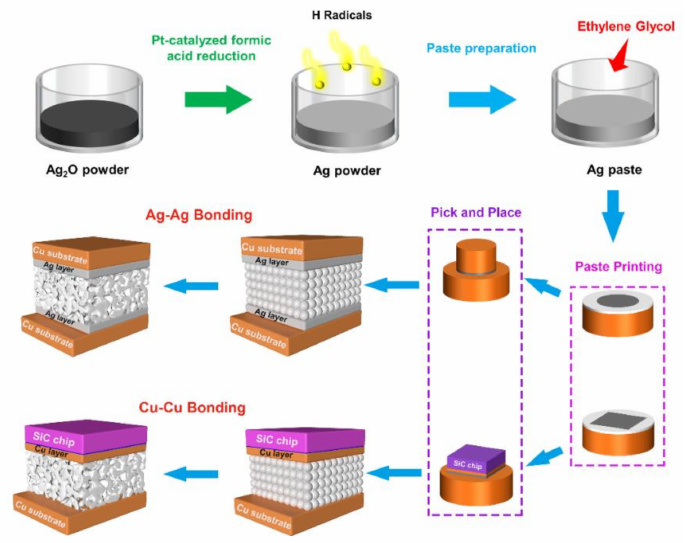
Figure 1. Schematic illustration of the experimental processes for Ag–Ag and Cu–Cu bonding.